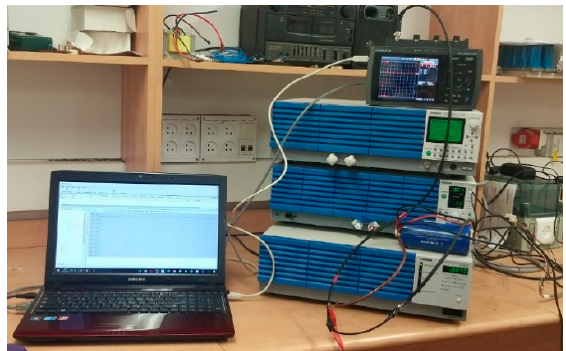
Figure 1. Experimental setup for the charging and discharging cycle on both capacitors.